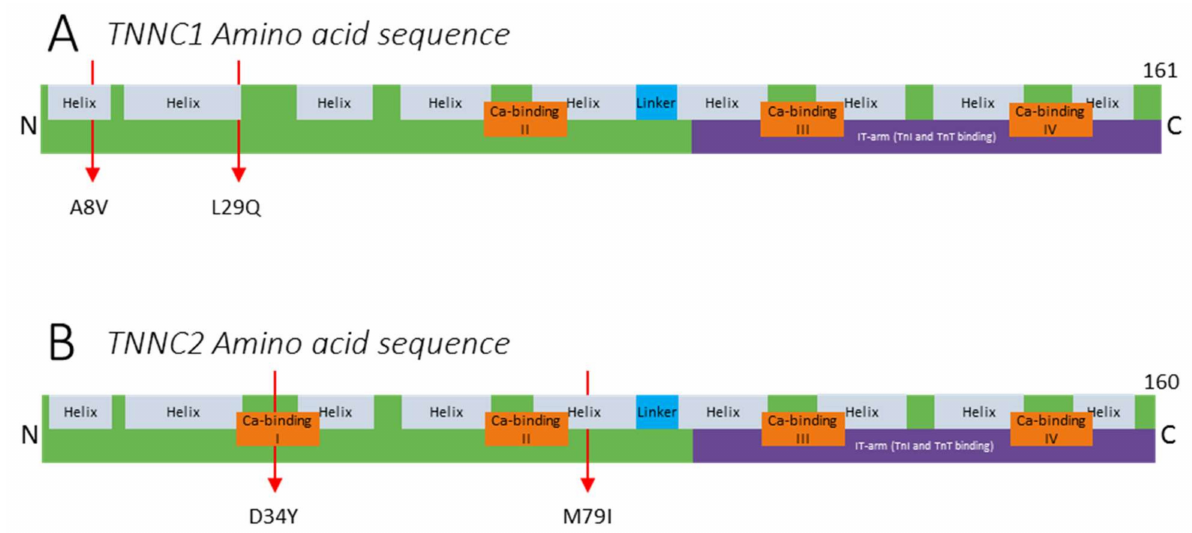
Figure 2. Protein structure and reported variants in ( A ) TNNC1 (UniProt (P63316, TNNC1_Human)) and ( B ) TNNC2 (UniProt (P02585,